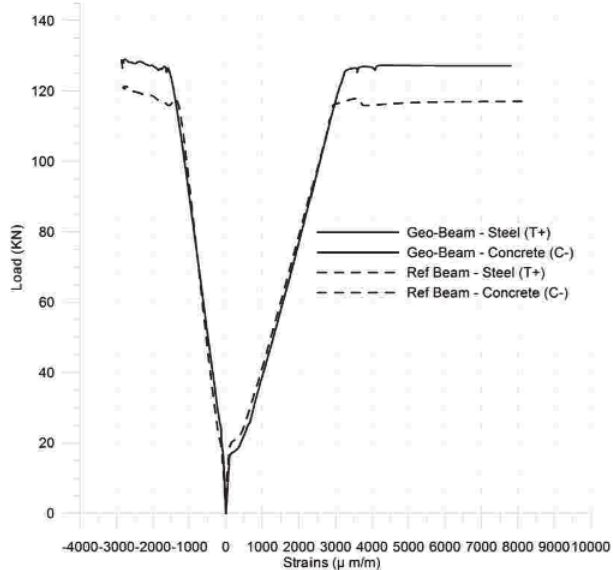
Figure 6 Separated load vs deformation curves of the steel and concrete components of the two